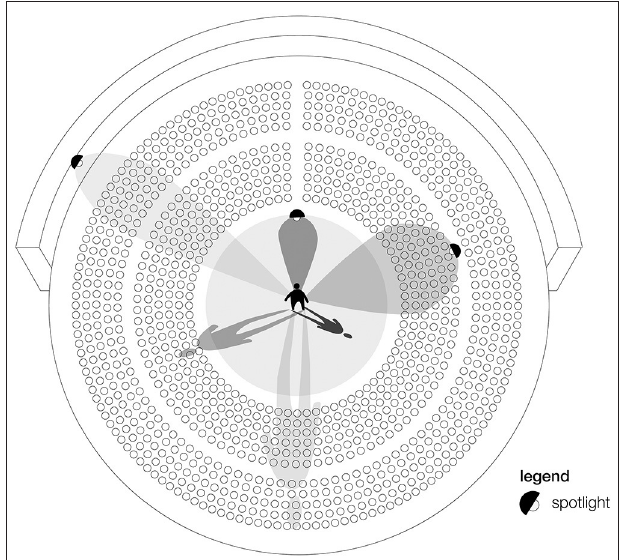
FIGURE 6 | Visualization of our explorative approach. The observed individual is located on the stage and is surrounded by their community (individuals sitting in the theater, including parents, family, healthcare professionals, educators, etc.). Depending on the strength of the spotlight (in our context, training-based rigor), a higher or lower visual acuity might be achieved and depending on the positioning of the spotlights, the dimension of the shadow